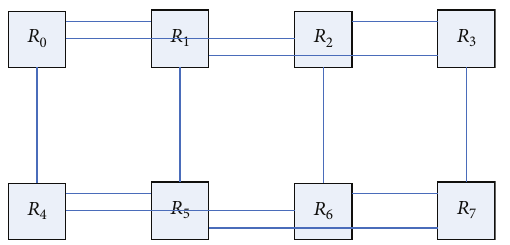
Figure 5: Planar butterfly network after changing the topology distribution.